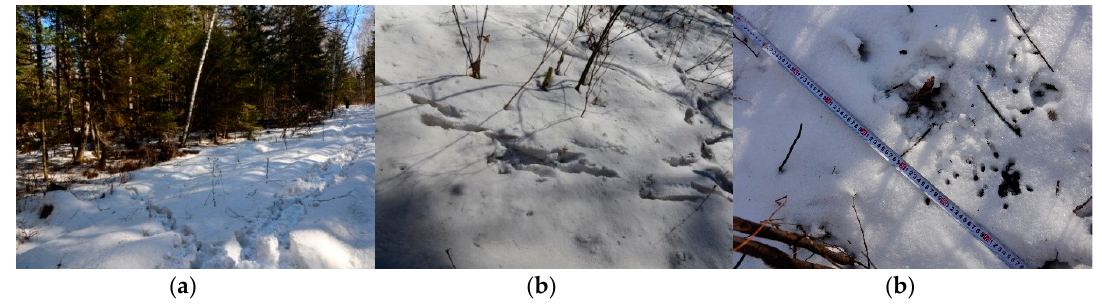
Figure 2. The point where we encountered the newly left deer trail ( a ). The newly left deer trails which were fresh, maintained their shape and were identifiable. ( b ), and the pellets sampled on the trails, which were black, round and moist ( c ).